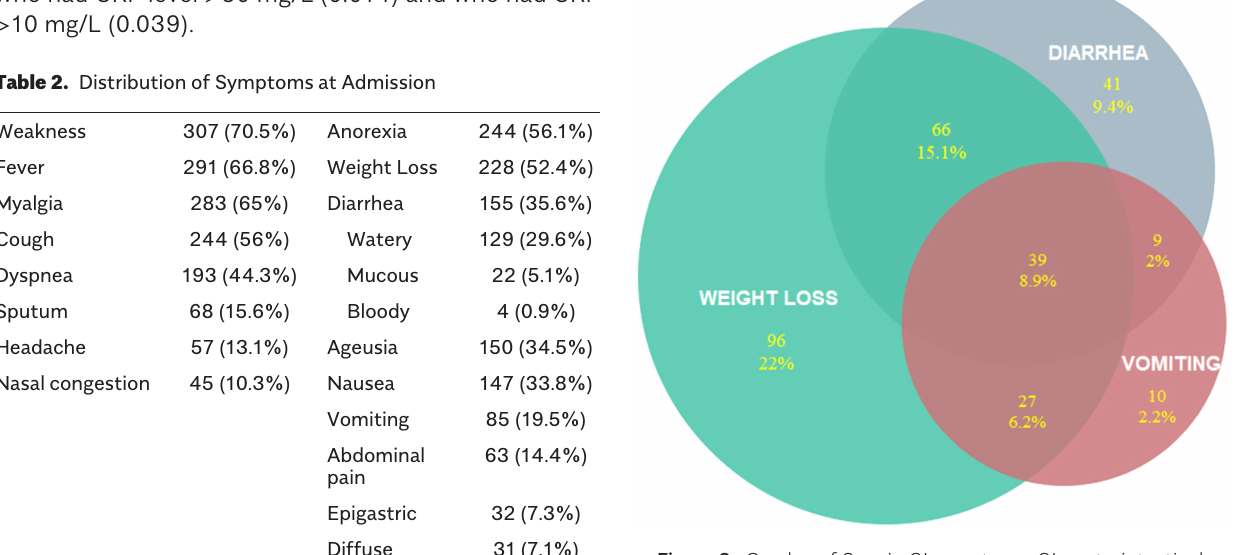
Figure 2. Overlap of 3 main GI symptoms. GI,